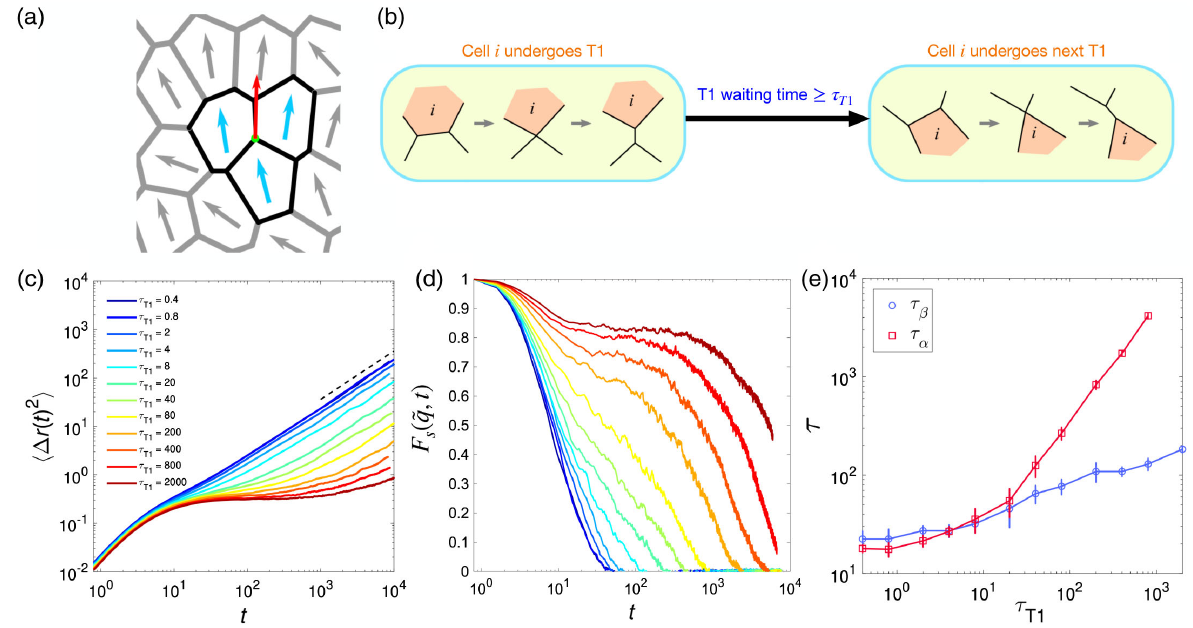
FIG. 1. Increased persistence of T1 events in the dynamic vertex model (DVM) slows down cell dynamics. (a) In the DVM, the dynamics of a vertex depends on motility of adjacent cells (also see the Appendix A). (b) Introducing the “ T1 stalling timescale ” τ which represents the time duration over which T1 transitions are stalled for any cell i . Consequently, τ the waiting time observed between successive T1 events involving cell i . This happens due to the stochastic dynamics of cellular junctions. (c) Mean-square displacements (MSDs) of the cell centers for fixed v 0 ¼ 1 . 6 at different τ 1 on a log-log scale, indicates the diffusive behavior. (d) Self-intermediate scattering function F s ð ˜ q; t Þ for the same v 0 at different τ ffiffiffiffiffi ffiffiffiffiffi p p A A Here, ˜ q ¼ π = , where is the unit of length in our model. (e) β - and α -relaxation timescales, τ β and τ α , respectively, as functions 0 0 of τ T 1